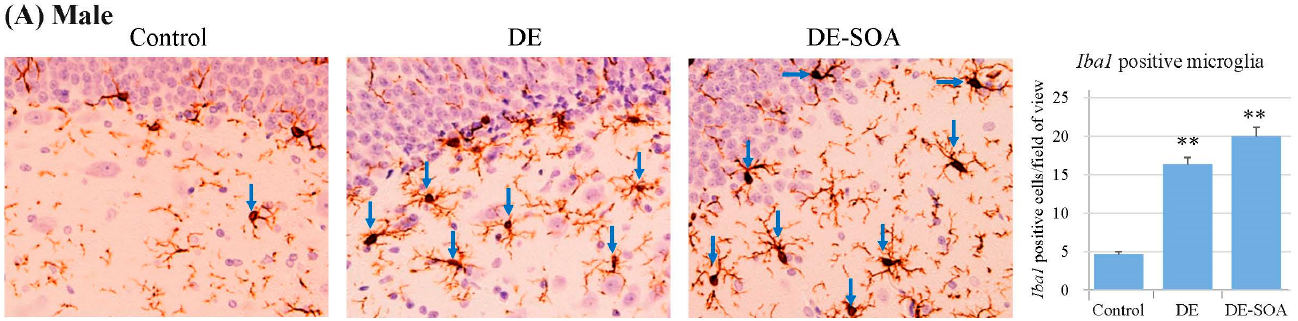
Figure 9. Representative photomicrographs of the dentate gyrus of the hippocampus. Microglia marker Iba1 immunoreactivity in 10-week-old ( A ) male and ( B ) female rats of the control and the DE- or DE-SOA-exposed groups. Blue arrows indicate activated microglia. (Scale bar = 50 μ m). Number of Iba1 -positive cells located within the DG area of the hippocampus was quantified in a high-power field under microscopy (histogram). ( n = 5, ** p < 0.01 vs. control). 3. Discussion The major findings of the present study were that the gestational and lactational exposure to DE-SOA induces the following responses: (1) anxiety-like behaviors such as decreased entry to the center and time stay in the center in OFT, decreased open arm entry and open arm time in EPM tests, and latency to approach and latency to eat food on the novelty day in NIH tests; (2) downregulation of anxiety-related gene serotonin receptor 5HT1A and neurotrophic factor BDNF ; (3) upregulation of proinflammatory cytokine IL- 1 β , COX2 and oxidative stress marker HO-1 ; and (4) increased microglia activation in the hippocampus in male and female rats. Our findings suggest that the perinatal exposure to DE-SOA induces anxiety-like behavior in rats by triggering neuroinflammation and neuropsychological disorders via neurological and immunological biomarkers in the brain. According to the WHO, air pollution is the fourth largest risk factor for global mortality [29]. Major air pollutants are organic hydrocarbons, particulate matter (PM), carbon monoxide (CO), nitrogen dioxide (NO 2 ), carbon dioxide (CO 2 ), and heavy metals [30]. The major sources of these air pollutants and heavy metals are from transportation [31]. Thus, traffic-related air pollution is a major contributor to global air pollution. Air pollution due to gasoline and diesel emissions from internal combustion engines of automobiles, trucks, locomotives, and ships leads to 800,000 premature deaths annually due to pulmonary, cardiovascular, and neurological complications [32]. People living and working in areas of heavy vehicle traffic have high susceptibility to mental health problems and learning and memory impairment such as anxiety, depression, and cognitive deficits. Using animal studies, we have reported that exposure to diesel exhaust and diesel engine derived secondary organic aerosols is associated with adverse effects in the central nervous system (CNS) via increased oxidative stress and neuroinflammation. We have shown that the effect of exposure to the nano-sized carbon black (14 nm) and nanoparticle- rich diesel exhaust particles causes alteration of brain neurotransmitters [1,2] and impairs